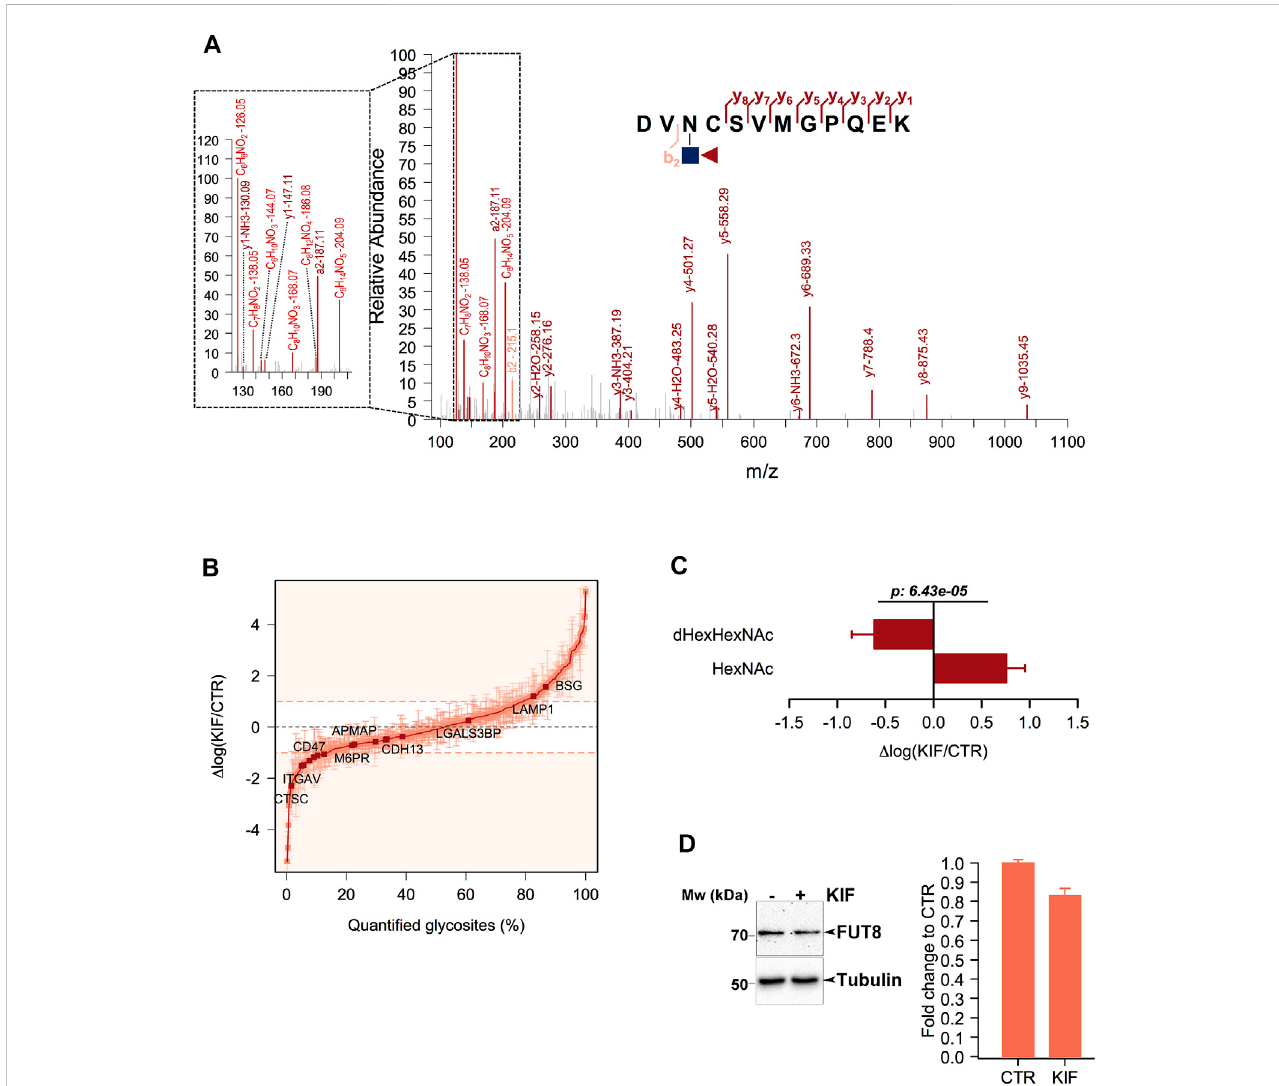
FIGURE 3 Analysis of core-fucosylated glycosites in KIF treated cells. (A). HCD MS/MS spectrum of the glycopeptide DVN(dHexHexNAc)CSVMGPQEK. Shown are the b and y ions. Inset: Low mass oxonium diagnostic ions identi fi ed in the MS/MS spectrum which con fi rms the modi fi cation. (B). Distribution of the log fold changes between KIF and CTR cells for core-fucosylated glycosites. Most of these show a lower relative abundance in KIF treated cells. (C). Analysis of the glycosites fucosylated and of the corresponding non-fucosylated glycosites from the same glycoproteins. Bars are mean of the core-fucosylated glycosites(n=15)andtheircorrespondingnon-fucosylatedglycosites(n=28)fromthesameglycoproteinsanderrorbarsareSEM.Forstatisticalsigni fi cance a Welch two sample t -test was used. (D). Left panel: Representative Western Blot of FUT8 relative expression in CTR and KIF-treated cells. Right panel: Estimated fold change after densitometry analysis of duplicate experiments as those in